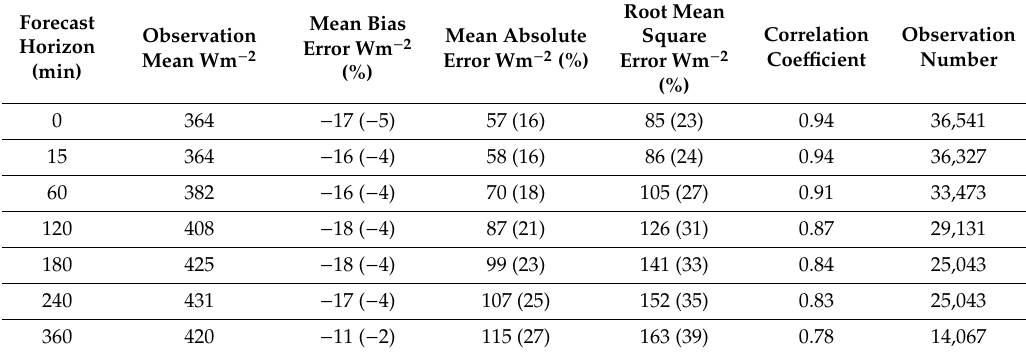
Table 2. Statistics of GHI satellite-based forecast at Palaiseau from 1 July 2017 to 30 June